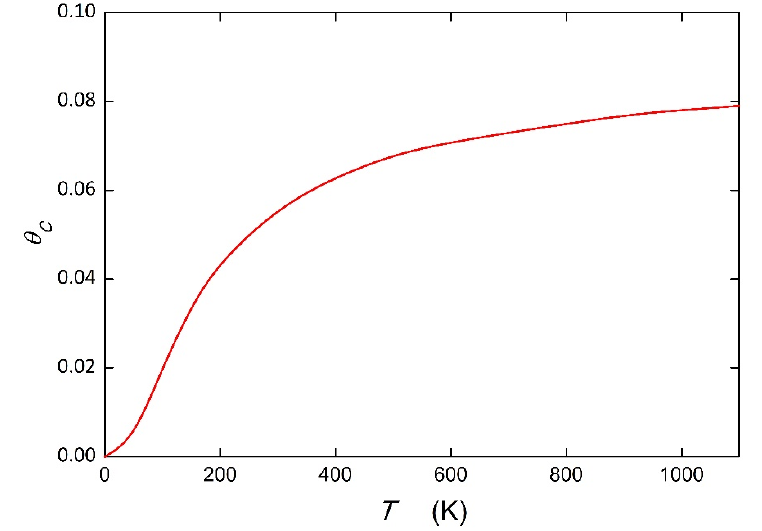
Figure 3. Temperature dependence of C segregation at the {112} grain boundary of bcc Fe calculated according to Equations (2)–(5), for X C = 0.0001. The value of ∆ H C = +1.3 kJ mol − 1 was taken from Reference [24], and the value of ∆ S 0 = +57.4 J mol − 1 K − 1 was determined using Equation (7) from [25]. The value α I = 7.7 kJ mol − 1 from [25] was applied.